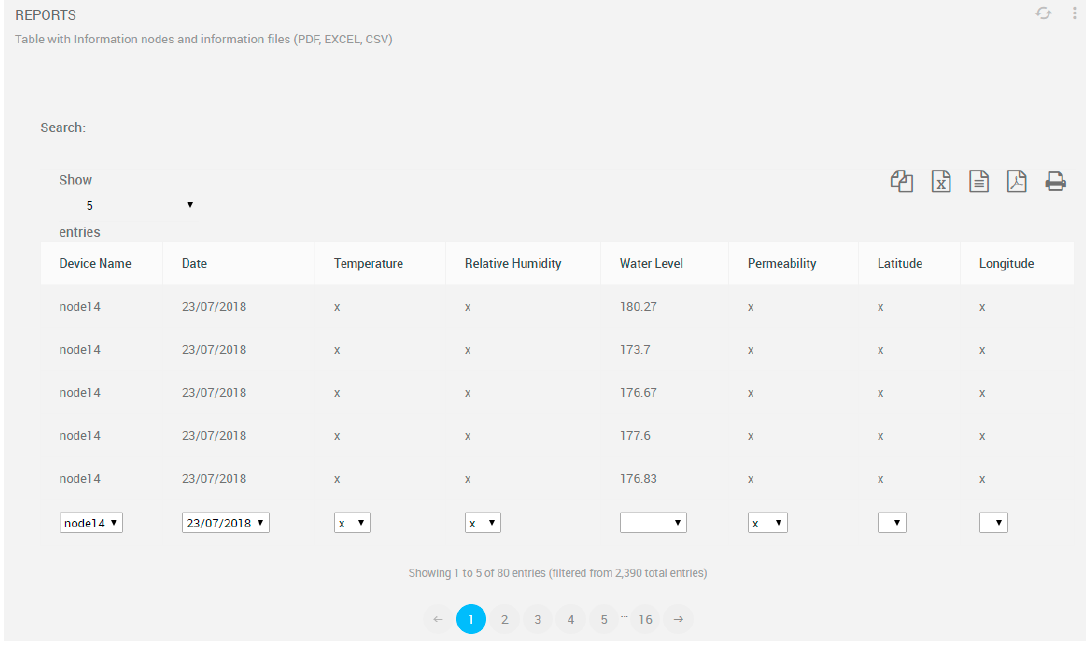
Figure 12. Report exportation view.